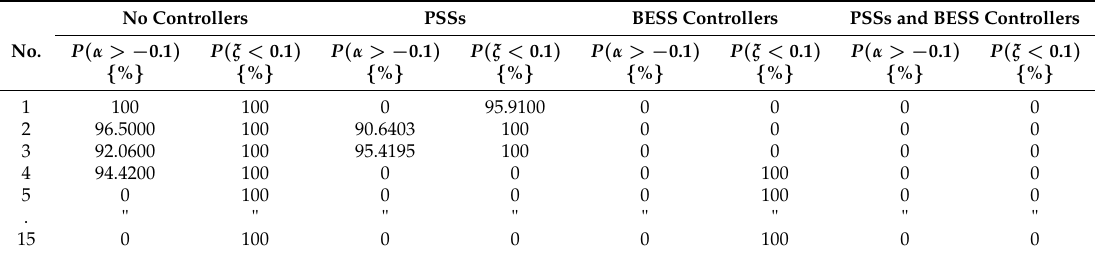
Table 2. Comparison of stability indices under different controller conditions using proposed method.